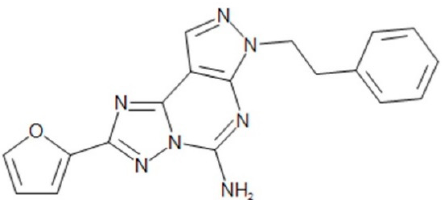
Figure1. Structureof5-amino-7-(2-phenylethyl)-2-(2-furyl)-pyrazolo(4,3-e)-1,2,4-triazolo(1,5-c)pyrimidine (SCH Figure 1. Structure of 5-amino-7-(2-phenylethyl)-2-(2-furyl)-pyrazolo(4,3-e)-1,2,4-triazolo(1,5-c) pyrimidine (SCH 58261) .